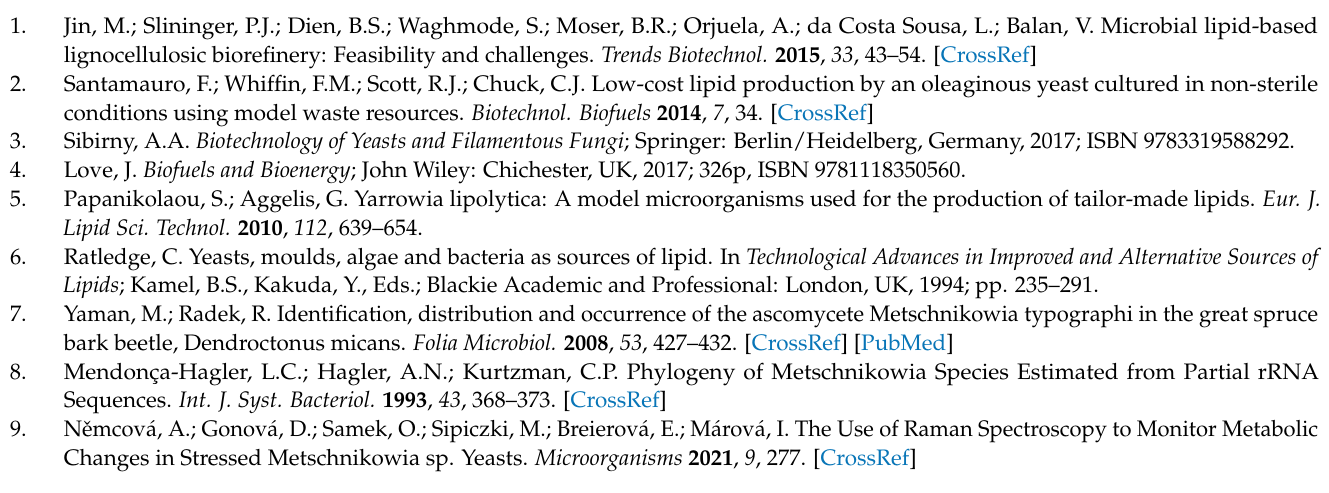
of the yeast M. sinensis MS 1244 on two different media. Figure S2. Raman scattering spectrum of intracellular lipids of the yeast M. pulcherrima 1232 and M. sinensis MS 1244 on the same media. Table S1. Composition of fatty acids (%) of glucose medium and C/N ratio 24, 97 and 150. Table S2. Composition of fatty acids (%) of glycerol medium and C/N ratio 24, 97 and 150. Table S3. Composition of fatty acids (%) of crude animal fat and its conversion in yeast fatty acids. Yeasts were cultivated in medium with crude fat and C/N ratio 24, 97 and 150. Table S4. Representation of SFA, MUFA and PUFA (%) in the yeast M. sinensis 1244 cultivated on glycerol media with C/N ratio 97 and 150 and calculated iodine number from the Raman spectrum (according to equation at [13]). Table S5. Representation of SFA, MUFA and PUFA (%) in the yeast M. pucherrima 1232 and M. sinensis 1244 cultivated on glycerol media with a C/N ratio of 150 and the calculated iodine value from the Raman spectrum (according to equation at